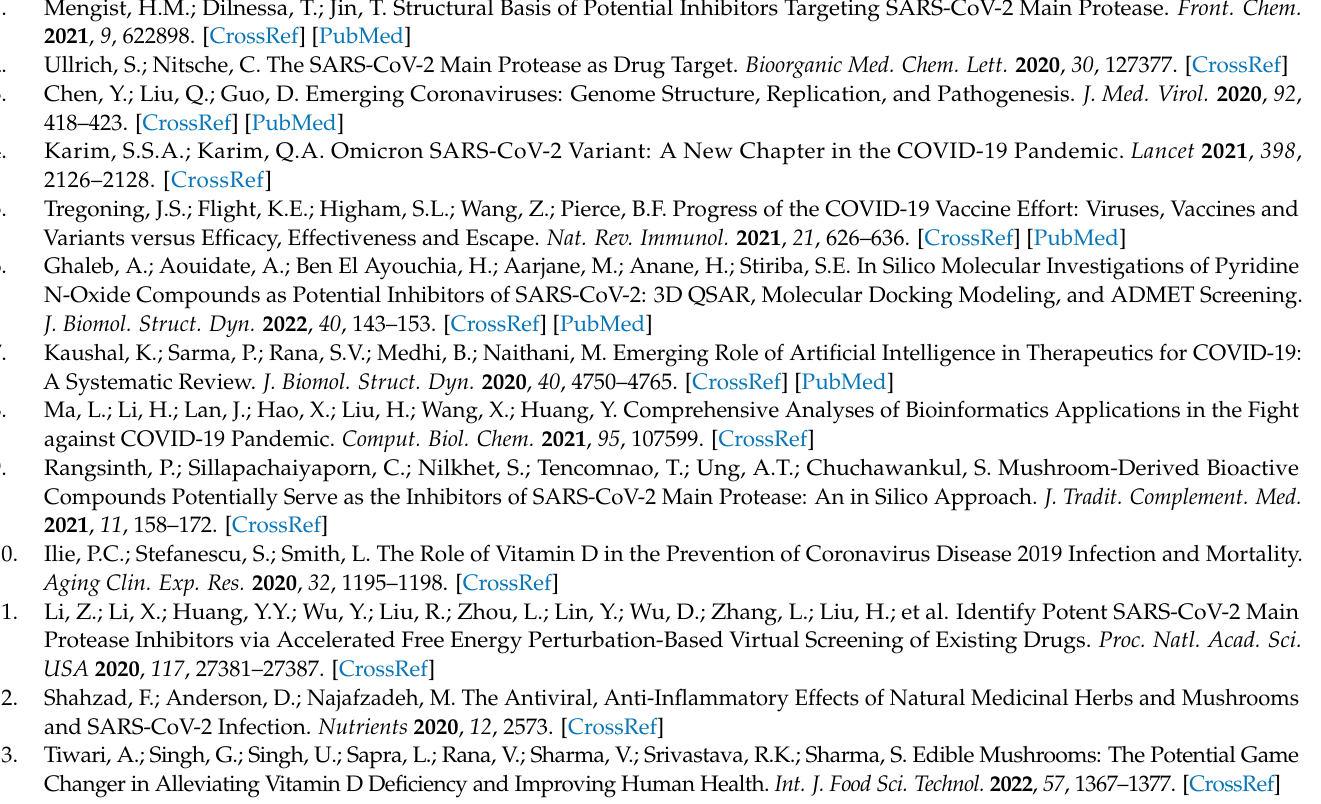
Ds molecules ( A ) Ergocalciferol (pre-vitamin-D 2 ) ( B ) Ergosterol (pro-vitamin-D 2 ) ( C ) Cholecalciferol (pre-vitamin-D 3 ) ( D ) 7-Dehydrocholesterol (pro-vitamin-D 3 ) ( E ) 22,23-dihydroergocalciferol (pre- vitamin-D 4 ) ( F ) 22,23-Dihydroergosterol (pro-vitamin-D 4 ); Supplementary Figure S2: Result of re- docking experiments green colored pose represents original conformation and yellow color